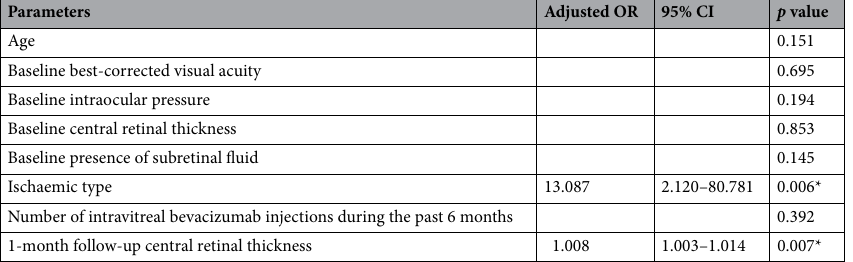
Table 3. Multivariate analysis of possible factors associated with neovascular glaucoma in central retinal vein occlusion patients. OR odds ratio, CI confidence interval. *Statistically significant by binary logistic regression analysis with backward elimination method (R 2 = 0.560, p = 0.831 by the Hosmer–Lemeshow test for goodness of